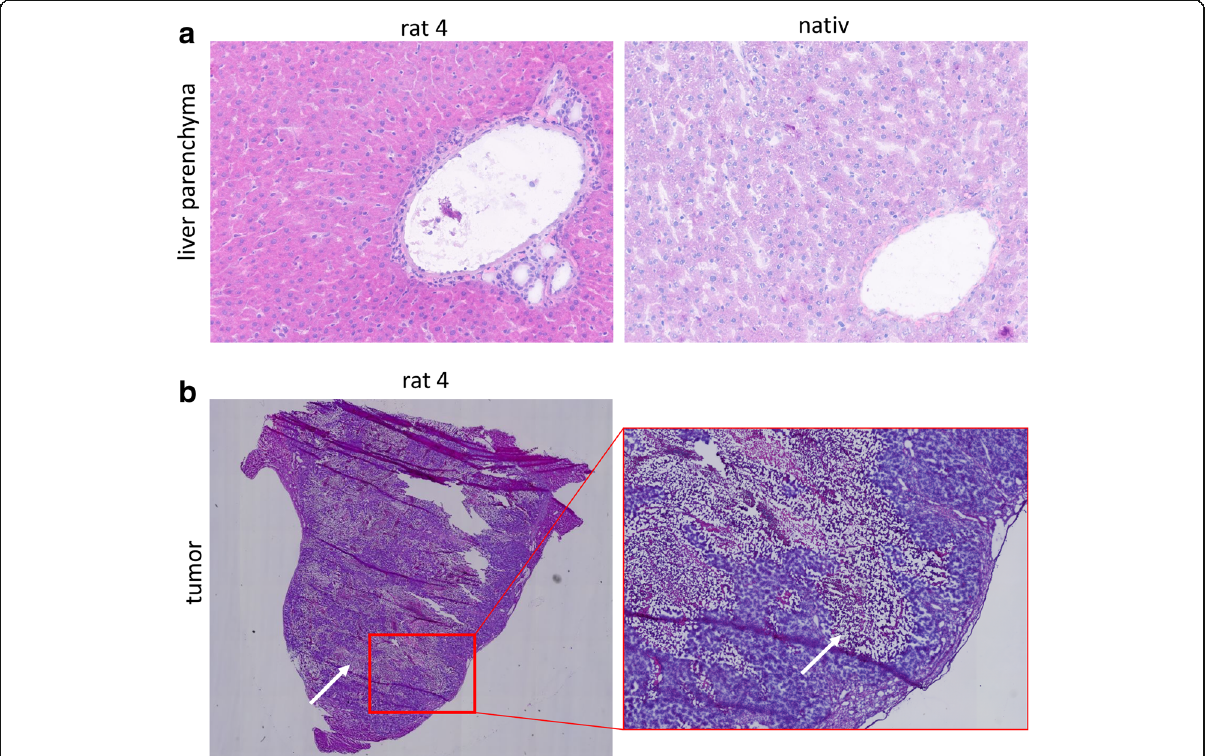
Fig. 5 Hematoxylin and eosin (H&E) stained snap frozen tissue sections. a Native and tumor-bearing (rat 4) liver parenchyma. b Within tumor tissue large areas are necrotic (white arrow)